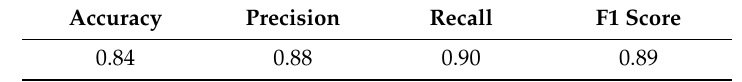
Table 8. Health diagnosis prediction results. Here, cognitive decline represents the positive